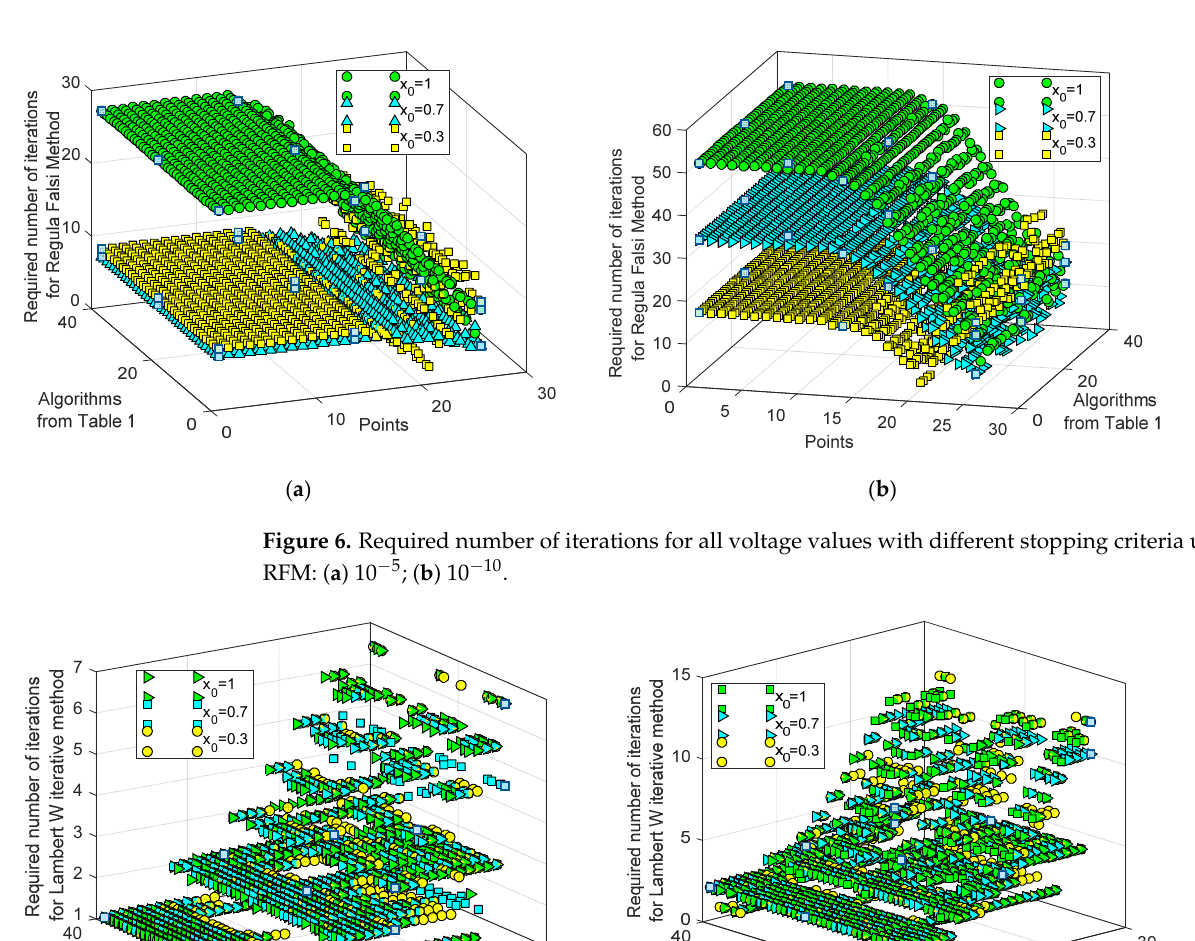
Figure 5. Required number of iterations for all voltage values with different stopping criteria using SM: ( a ) 10 − 5 ; ( b ) 10 − 10 .